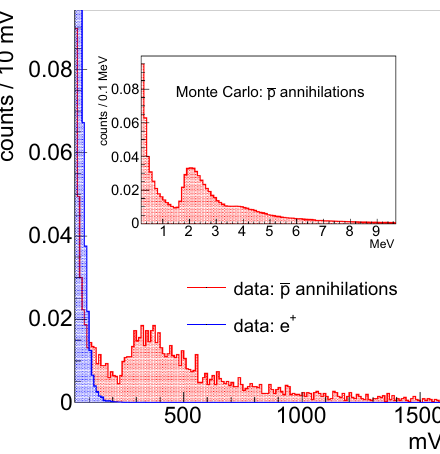
Fig. 2 External scintillator detector array (ESDA) amplitude spectra. The red plot in the main image shows the measured photomultiplier amplitude spectrum (mean value of the two photomultiplier signals contemporary within 50 ns) in the case of annihilation of (cid:1) p on the walls of the (cid:1) H f the signal expected in case of (cid:1) H production. The blue curve shows the distribution of the amplitudes of signals detected 1 μ s after the e + implantation in the target, without trapped (cid:1) p. The two plots are normalized to unit area. The inset shows the distribution of the energy deposit in the ESDA obtained with a Geant4 simulation of (cid:1) p annihilating on the wall of the (cid:1) H f . The Monte Carlo and measured distributions are remarkably similar: trap the peak at 353 mV in the red plot of the main graph corresponds to the peak energy deposit of 2.14 MeV in the plot in the